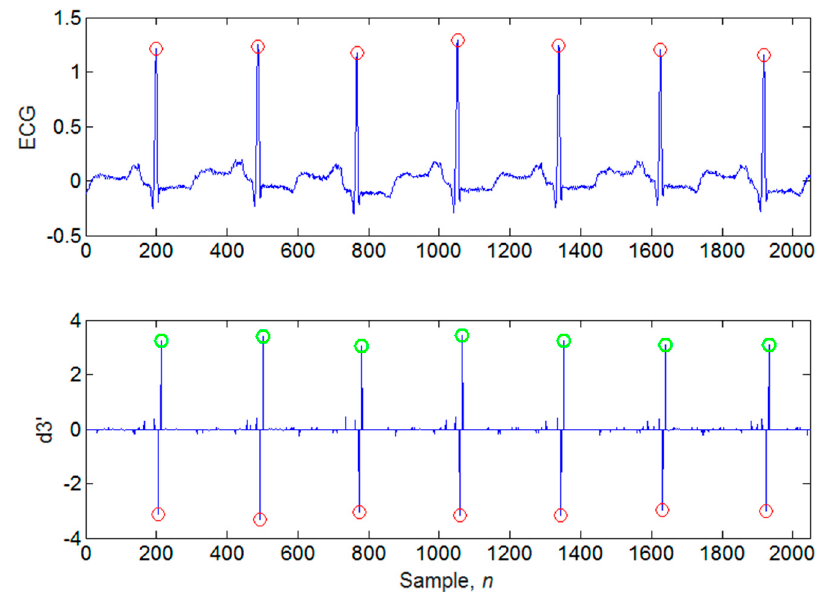
Figure 9. Illustration of the identifications of QRS peaks for Case 1.